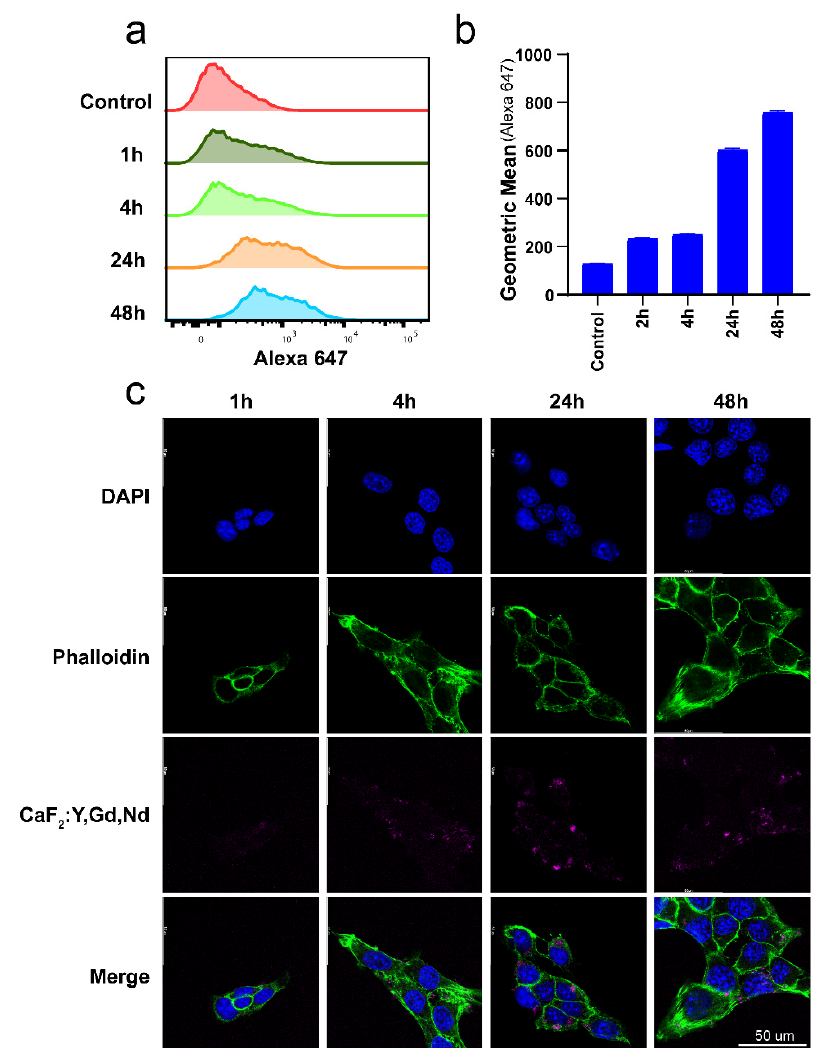
Figure 6. Uptake of CaF 2 :Y,Gd,Nd NPs by 4T1 cells. ( a ) Representative flow cytometric plots and ( b ) flow cytometric analysis of CaF 2 :Y,Gd,Nd NPs uptake by 4T1 cells; ( c ) confocal microscope images of CaF 2 :Y,Gd,Nd NPs uptake after 1, 4, 24, and 48 h. Cell nuclei are stained blue (DAPI), actin cytoskeleton is green (Phalloidin), and CaF 2 :Y,Gd,Nd NPs are displayed in magenta. Scale bar = 50 μ m.